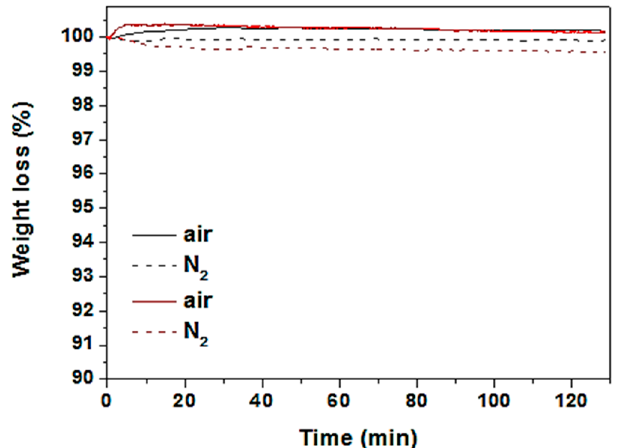
Figure 11. TGA curves of pristine FAPbI 3 (black) and CuSCN (red) powders at 125 °C in air for 2 h, equivalent to the thermal stability testing conditions. Reproduced with permission from Reference [75]. Wiley 2016.